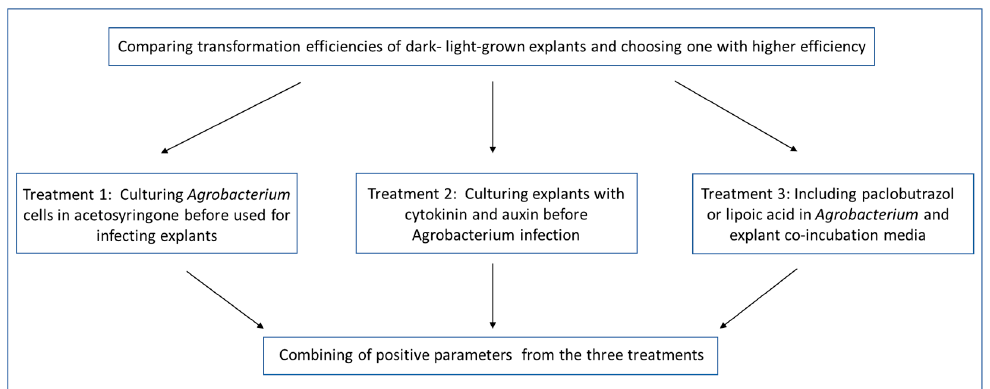
Figure 6. A flowchart of testing different parameters to improve transformation efficiency of ‘Car- rizo’ citrange.